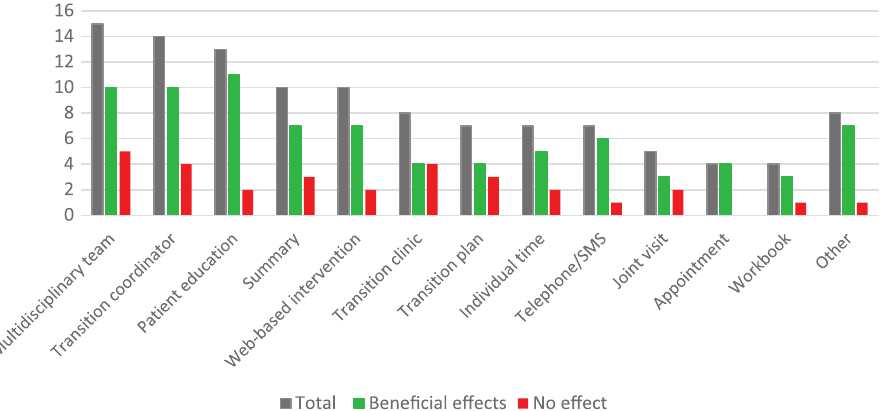
Figure 2: Number of studies that evaluated certain intervention components. Total: total number of studies. Beneficial effects: Number of studies showing a significantly better outcome in the intervention group or in measurements after intervention compared to the control group or measurements before intervention. No effects: Number of studies showing no significant differences between groups or between measurements before and after